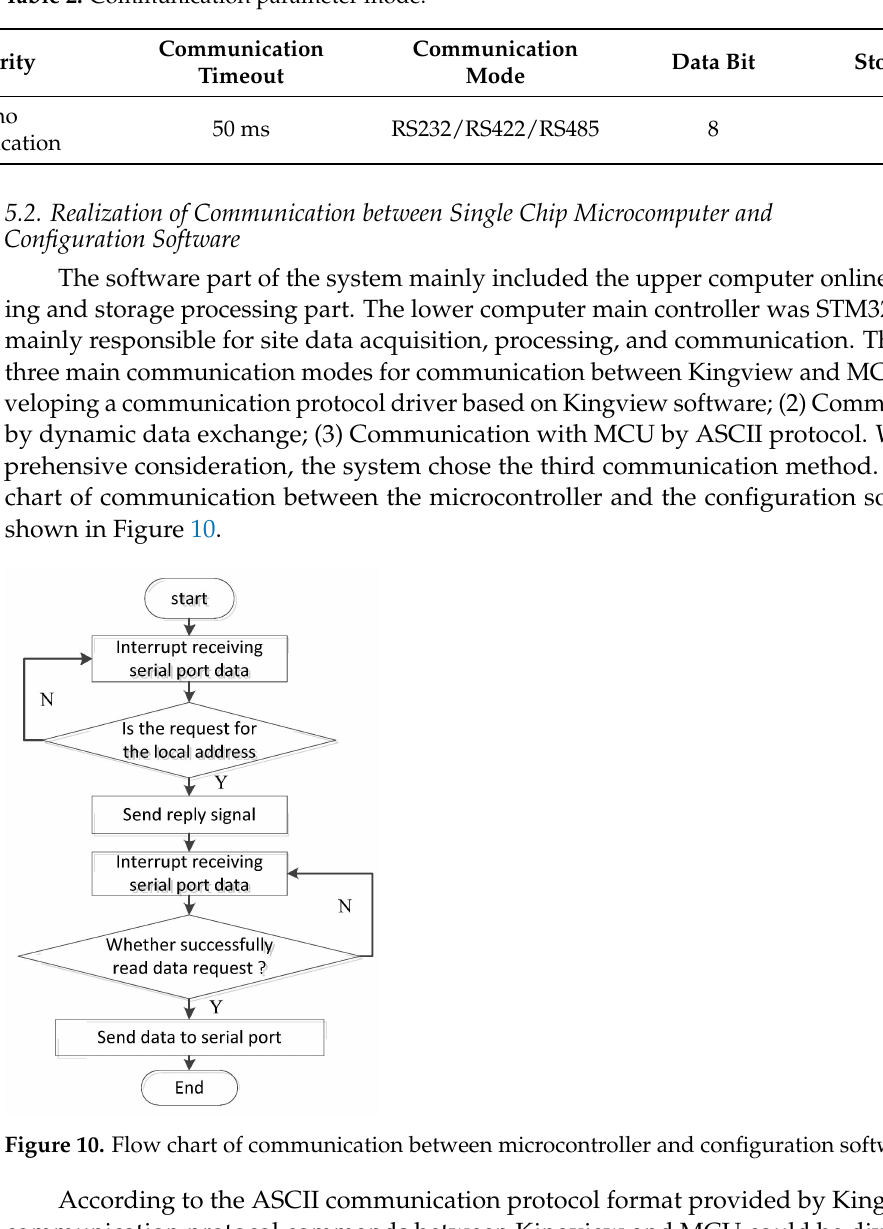
Table 2. Communication parameter mode.